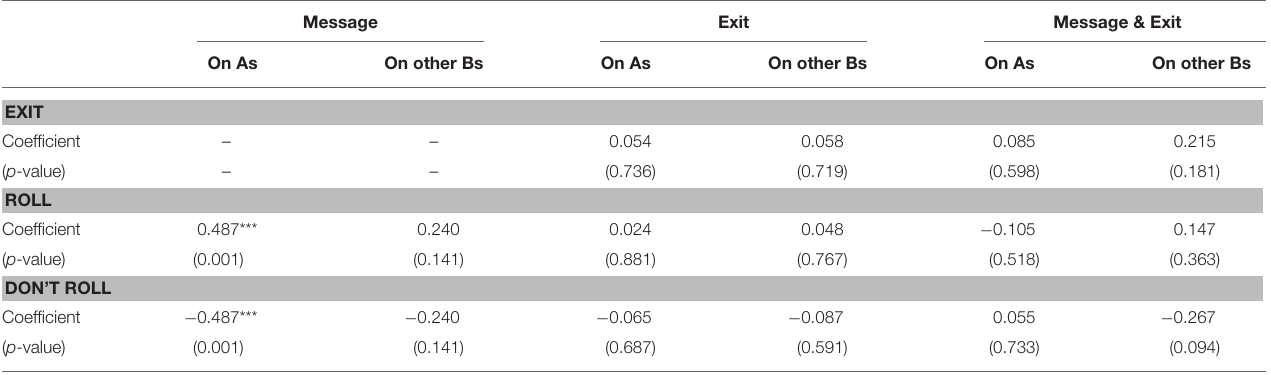
TABLE 2 | Correlation between Bs’ second-order empirical expectations on A, Bs’ empirical expectations on other Bs and Bs’ behavior.